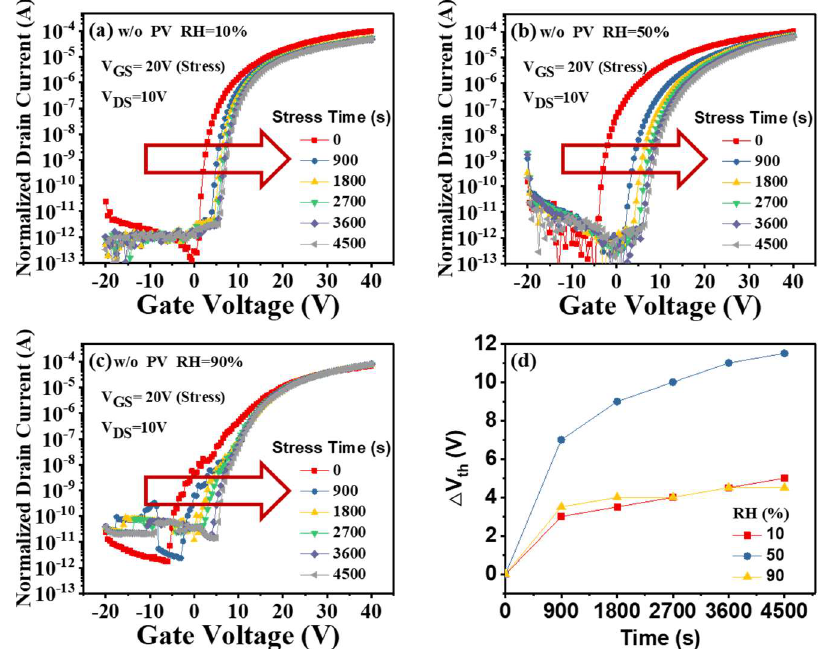
Figure 2. Transfer characteristics of the unpassivated a-IGZO TFTs as a function of the positive gate bias-stress (PGBS) time under relative humidity (RH) of ( a ) 10%, ( b ) 50%, and ( c ) 90%, respectively; ( d ) variations of the ΔV th with PGBS time for the a-IGZO TFT devices.